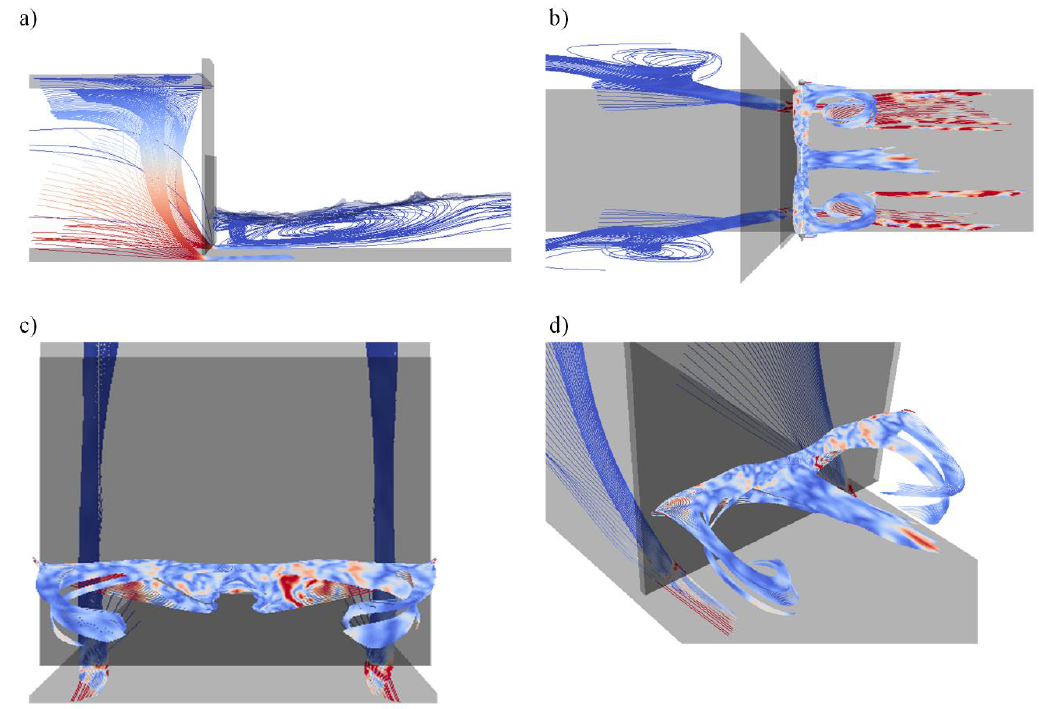
Figure 7. Visualization of time-averaged three-dimensional flow structure using streamlines colored with pressure in ( a ) and vorticity magnitude in the remaining images: ( a ) side view; ( b ) top view; ( c ) front view; ( d ) three-dimensional view. Water 2020 , 12 , x FOR PEER REVIEW 12 of 18